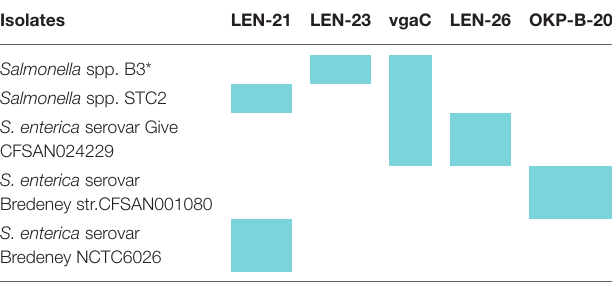
TABLE 2 | Specific resistant genes of Salmonella spp. B3 and STC2.